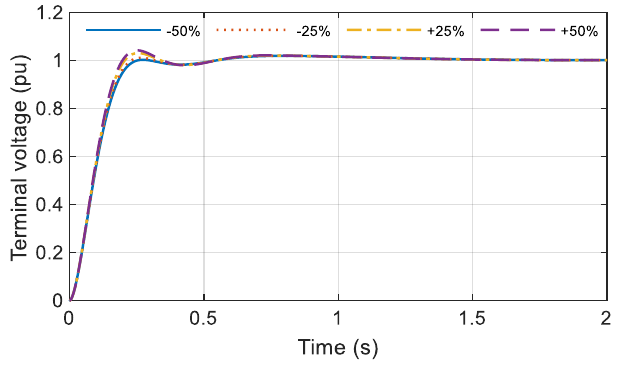
G. Mathematics 2020 , 8 , x FOR PEER REVIEW